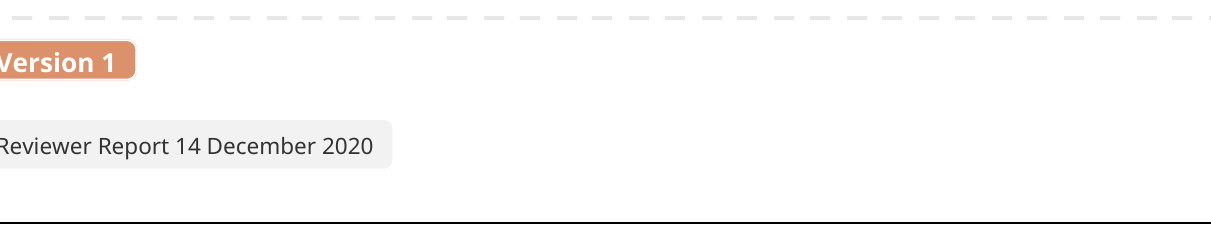
Figure 2: The Drosophila egg chambers have been removed but the text (“Testing of workflow”) still refers to them. Perhaps say “data not shown”? Figure 2B: I assume "color blind save" should read "color blind safe"? ○ Competing Interests: No competing interests were disclosed.